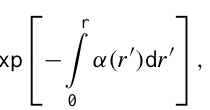
( 1 + δ) 2 (S c = 18 2 S c ( 1 − δ) 2